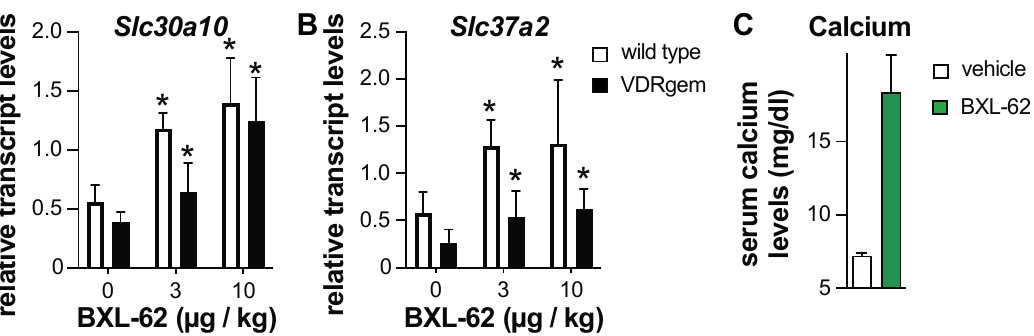
Figure 5. Effect of BXL-62 on intestinal VDR target gene transcript levels and serum calcium levels. Relative duodenal transcript levels of Slc37a2 ( A ) and Slc30a10 ( B ) in wild type (white bar) and VDRgem (black bar) mice after a 6-h oral administration of vehicle, 3, and 10 µ g/kg of BXL-62. The transcript levels of the 18S housekeeping gene were used as internal control; ( C ) Serum calcium levels of VDRgem mice 24-h after 4 administrations of vehicle (oil), or 10 µ g/kg BXL-62 on 4 consecutive days. * p < 0.05 vs. vehicle. n > 3 mice/group.